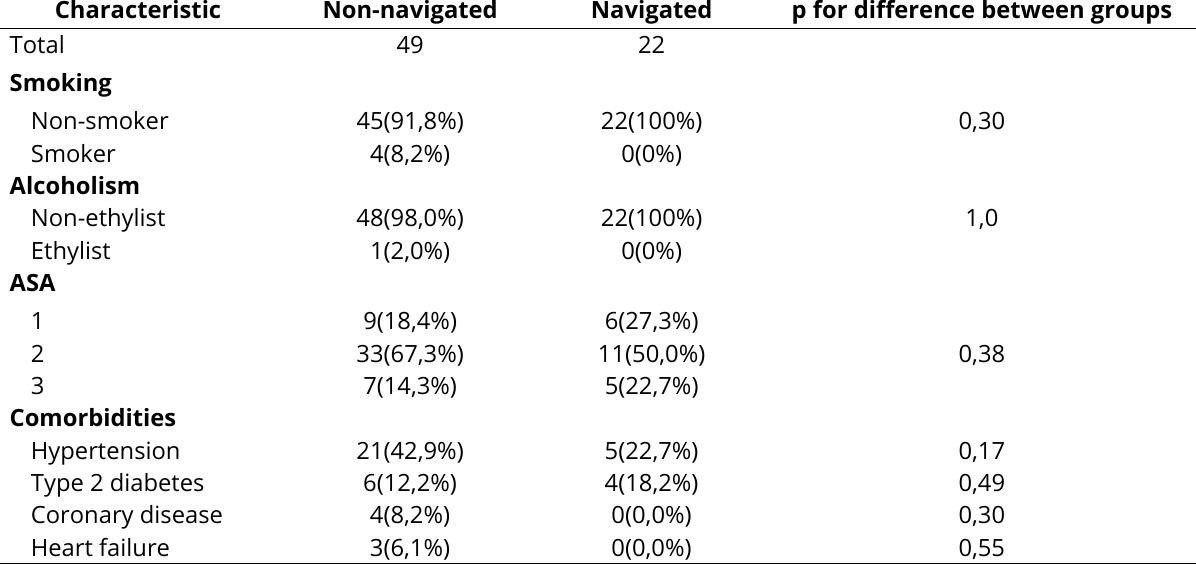
Table 1. Characteristics of navigated and non-navigated patients (N=71).